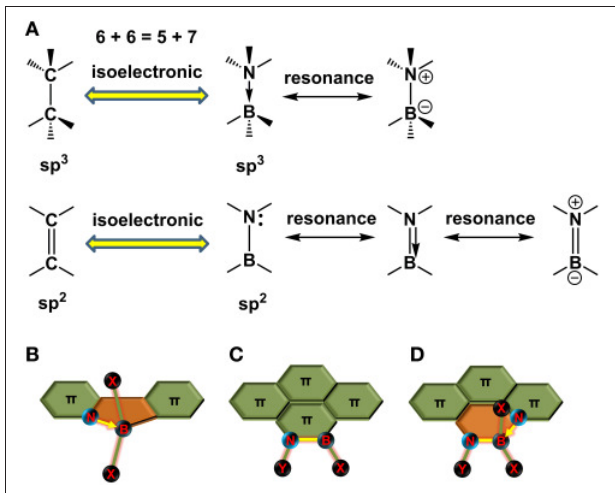
FIGURE 2 | Isoelectronic structures of CC and BN units (A) and schematic diagram of π -electronic units containing B ← N coordination bond (B), B-N covalent bond (C), and N-B ← N group (D) . X, Y, and Z represent the halogen atoms, alkyl chains, or phenyl